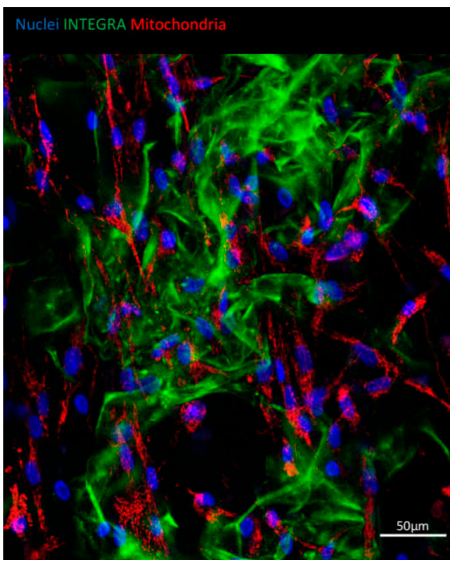
Figure 3. ASCs growing on Integra ® DRT. Viability of cells evidenced by a mitochondrial high membrane potential of ASCs shown with tetramethylrhodamine, ethyl ester (TMRE) staining (red). Nuclei were counterstained with Hoechst 33342 (blue); autofluorescence of Integra ® DRT was visualized in the green channel.